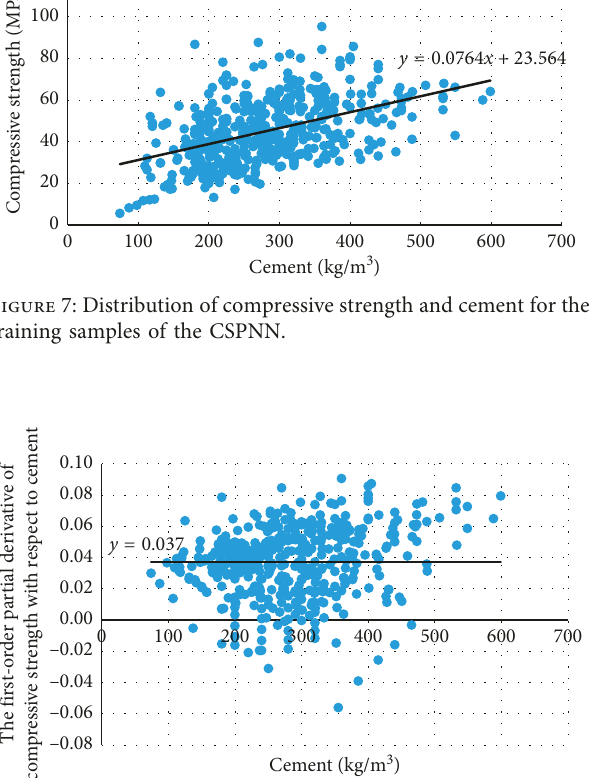
Figure 8: Distribution of cement and the first-order partial de- rivative of compressive strength with respect to cement for the training samples of the CSPNN.